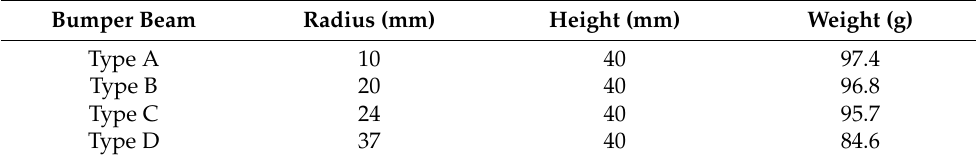
Figure 4. The cross-section geometry of the bumper beams. Table 1. Main geometric variables of the four bumper beam cross sections. Table 1. Main geometric variables of the four bumper beam cross